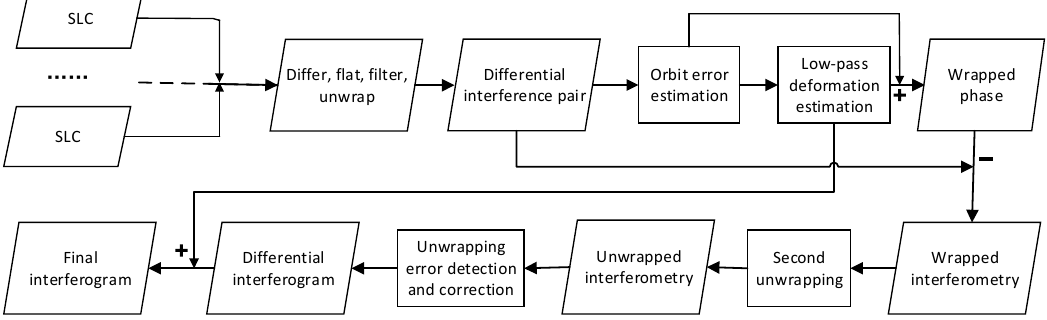
Figure 1. Framework of interferogram unwrapping, error detection and correction. The boxes represent the detailed operations, the parallelograms indicate the processed results and the arrows point to the next process.